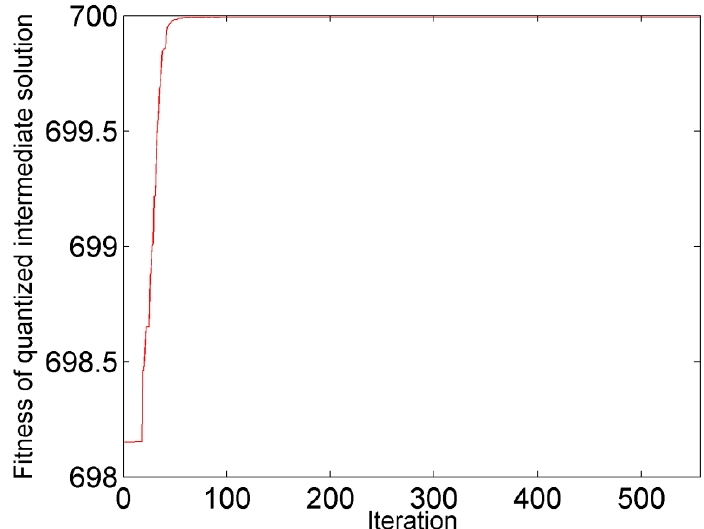
Figure 2. The convergence diagram of the affinity propagation (AP) algorithm (corn data) in the first round: Iterations vs. Fitness (net similarity) of quantized intermediate solutions. When the iteration is 562, the network is converged.